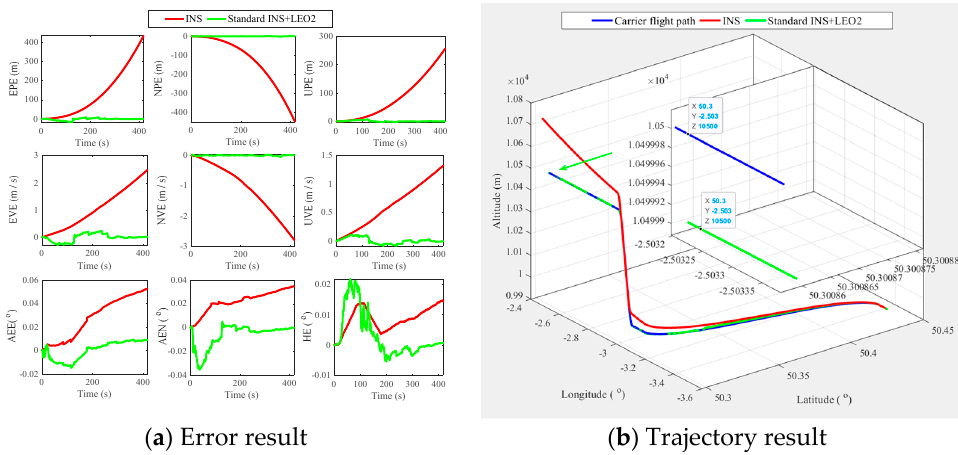
Figure 3. Standard INS+LEO2-satellite integrated navigation positioning results.